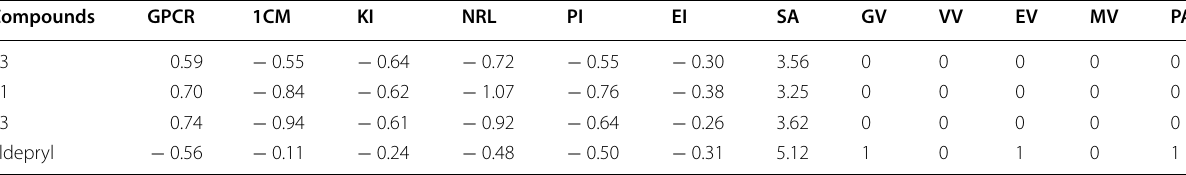
Table 10 Bioactivity index and medicinal chemistry accessibility of designed inhibitors Compounds